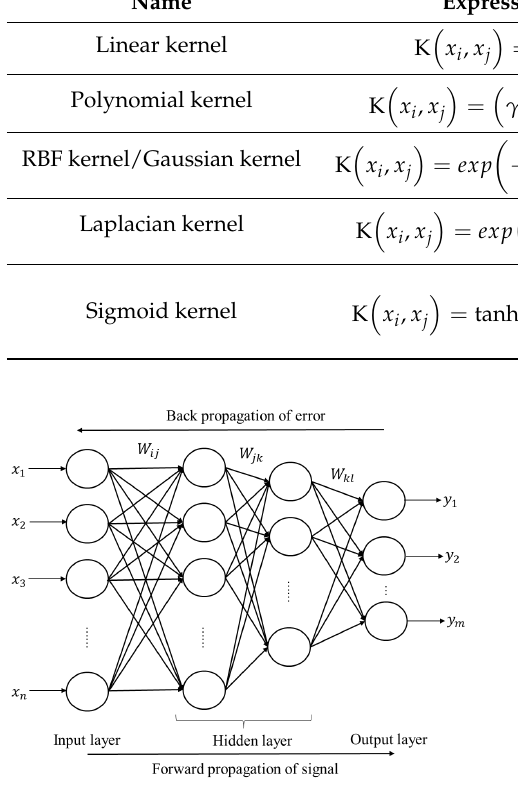
Figure 3. A structure diagram of a BP neural network.